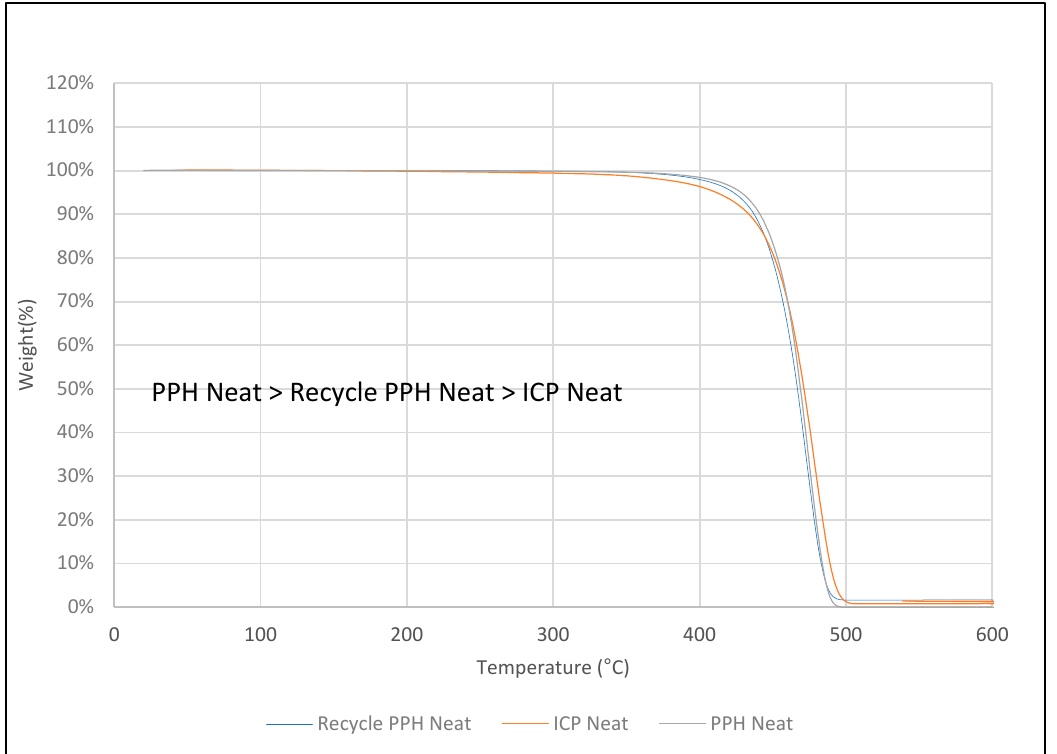
Figure 14. TGA of different PP matrices.